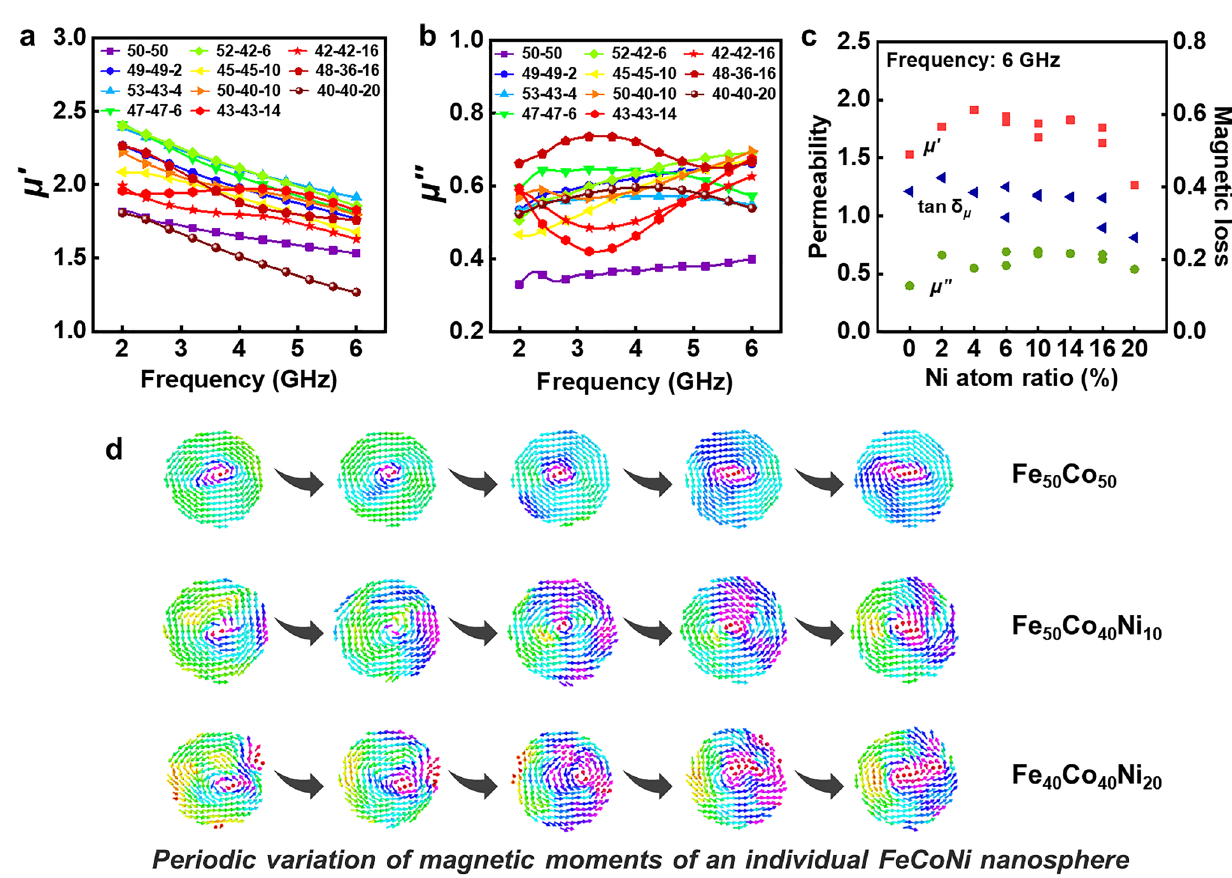
Fig. 6 a μ ′ and b μ ′′ of FeCoNi NP of different Fe, Co, Ni ratios. c The permeability and magnetic loss values of FeCoNi NP with different Ni atom ratios under 6 GHz. d Micromagnetic simulation of FeCoNi spheres with cyclical variation in different Fe/Co/Ni ratios. The external mag- netic field frequency is 6 GHz, and the diameter of the microsphere is 200